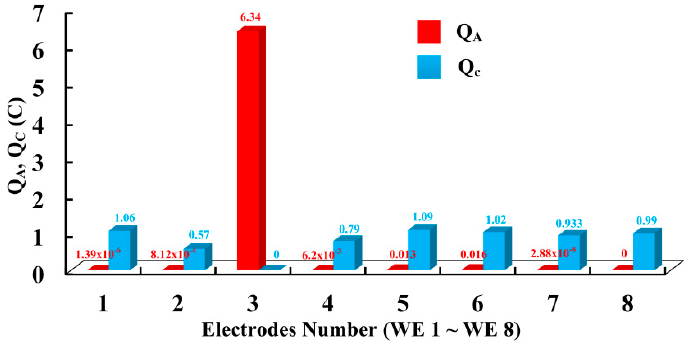
Figure 5 Anodic and cathodic electric charges of the electrodes. Figure 5. Anodic and cathodic electric charges of the